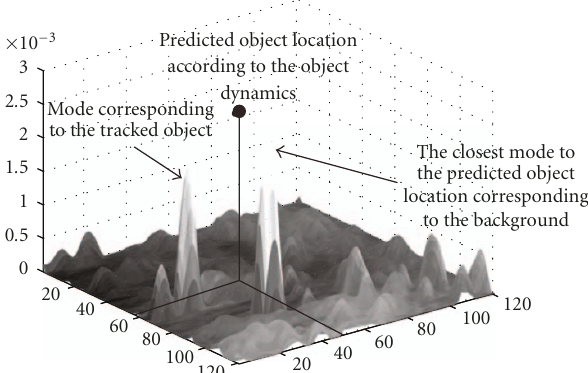
Figure 2: Multimodal LoG filter response related to Figure 1(b).